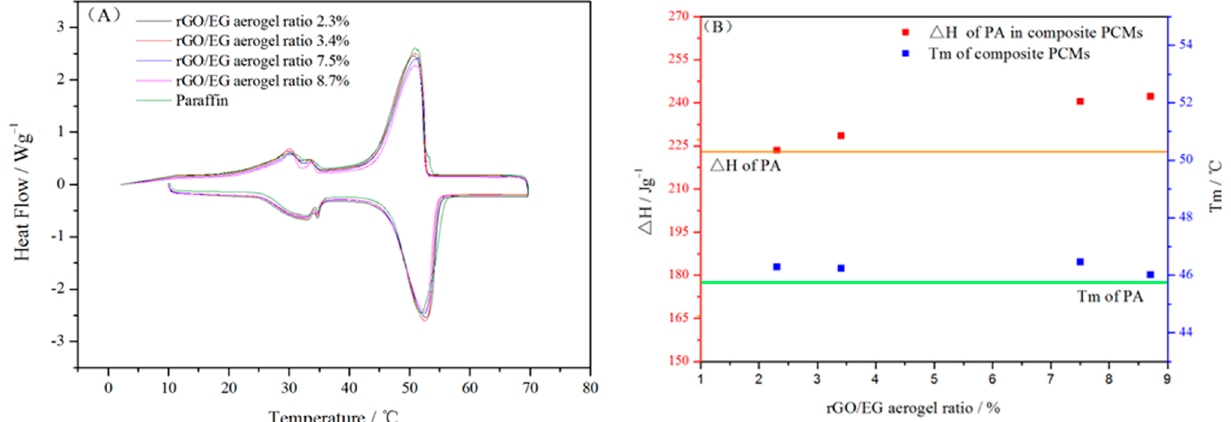
Figure 7. Differential scanning calorimeter (DSC) curves of paraffin and composite PCM ( A ); phase change properties of paraffin in composite PCM ( B ).